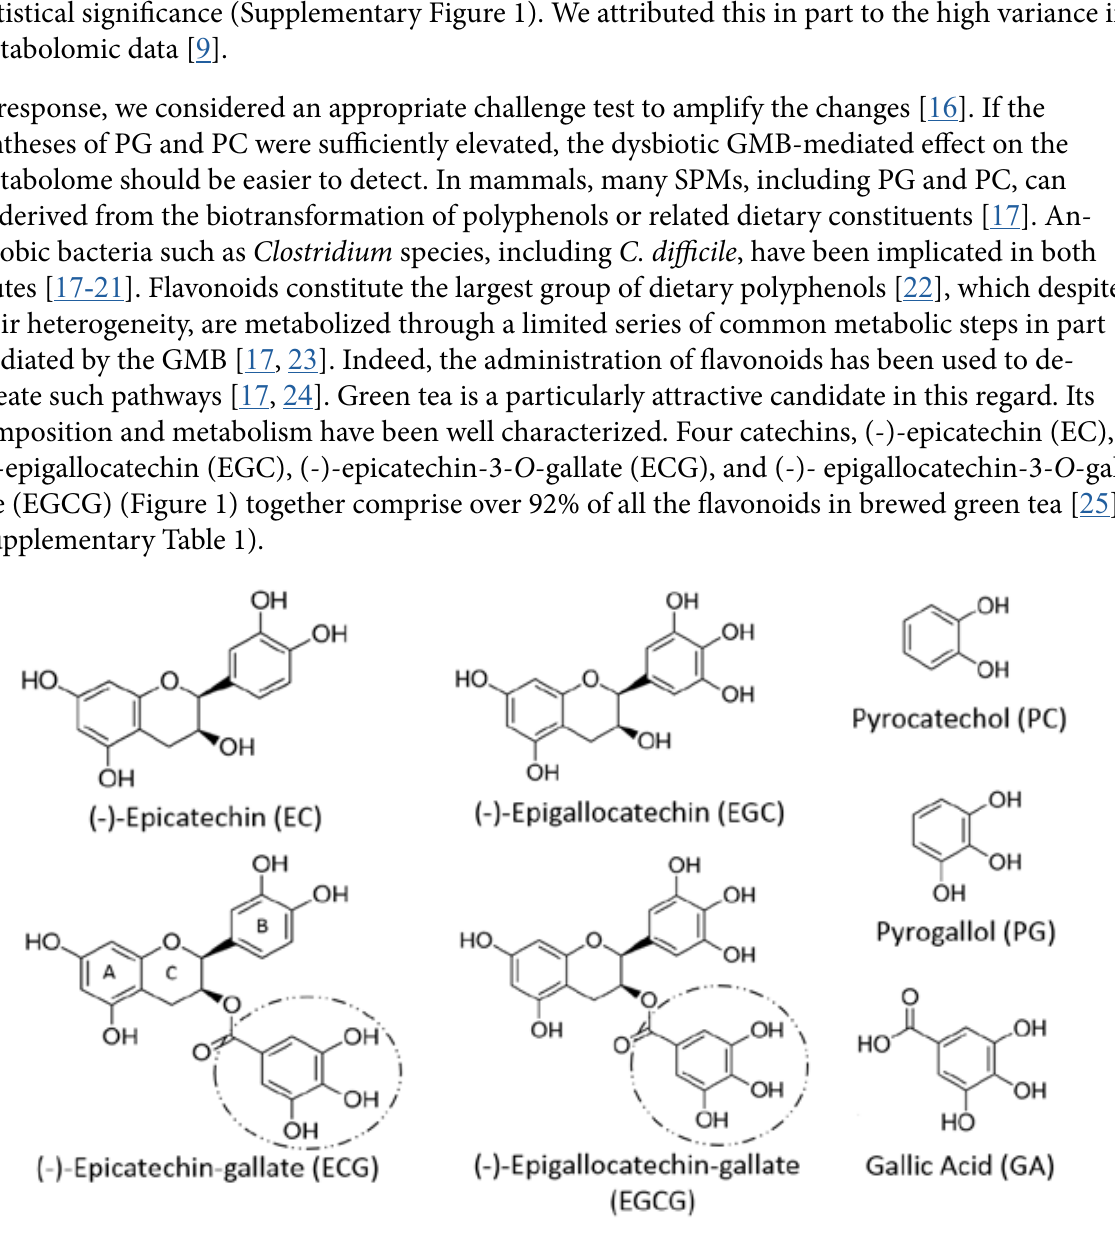
Figure 1. Structures of the principal flavan-3-ols in green tea ((-)-Epicatechin, (-)-Epicatechin-gallate, (-) Epigallocatechin, (-)-Epigallocatechin-gallate) and of their galloyl-derived metabolites (pyrocatechol, pyrogallol, and gallic acid). The phenolic rings (“A” and “B”) and the pyran ring (“C”) of the flavan nucleus are designated in the figure for (-)-Epicatechin-gallate. The galloylated ester moieties (circled) attached to ring “C” can be cleaved by gut